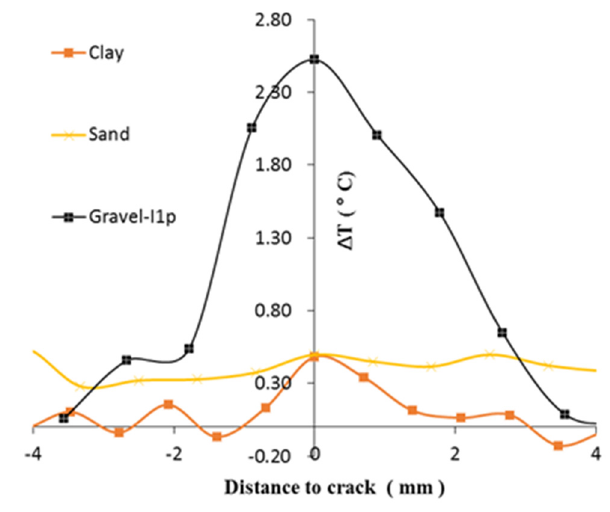
Figure 18. Comparison of temperature profiles across cracks during plastic deformation.